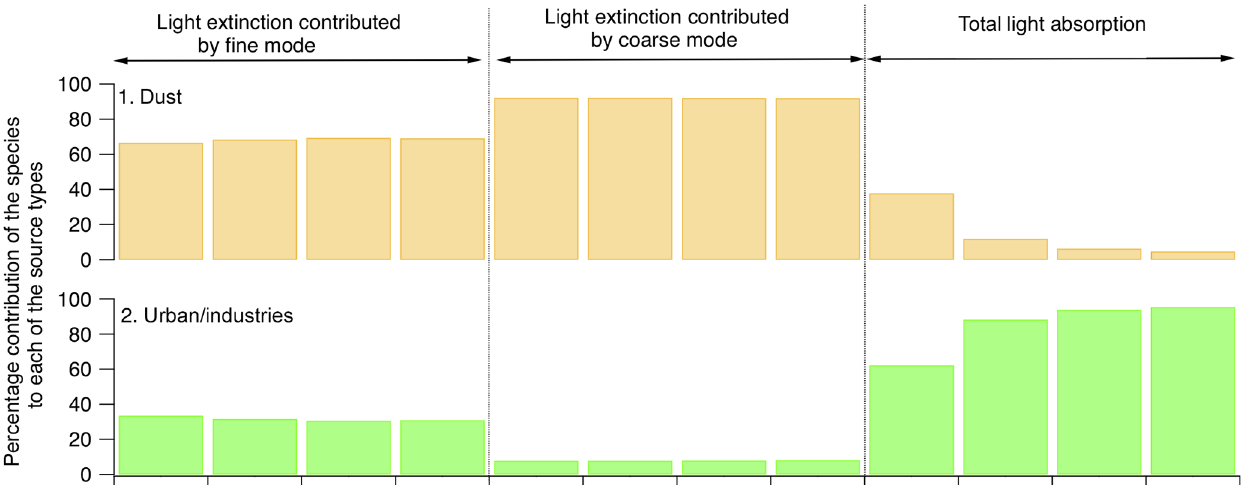
Figure A1. Optical source profile for the Capo Verde dataset. y axis: percentage of x -axis category associated with each derived source; x axis: extinction optical depth (AOTExt) and absorption optical depth (AOTAbsp) at wavelengths of 440, 675, 781, and 1018nm (F: fine mode; C: coarse mode; T: total).